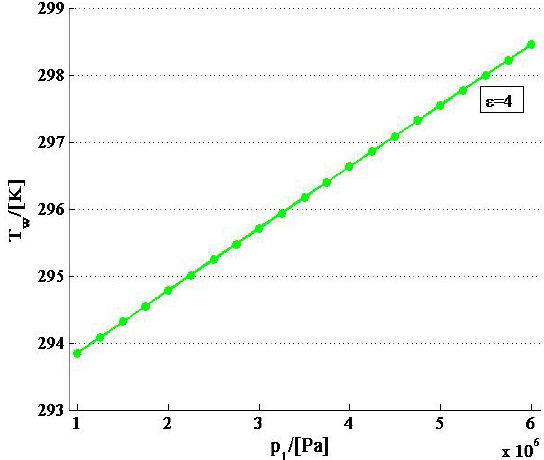
Figure 5. Water temperature various with pre-set